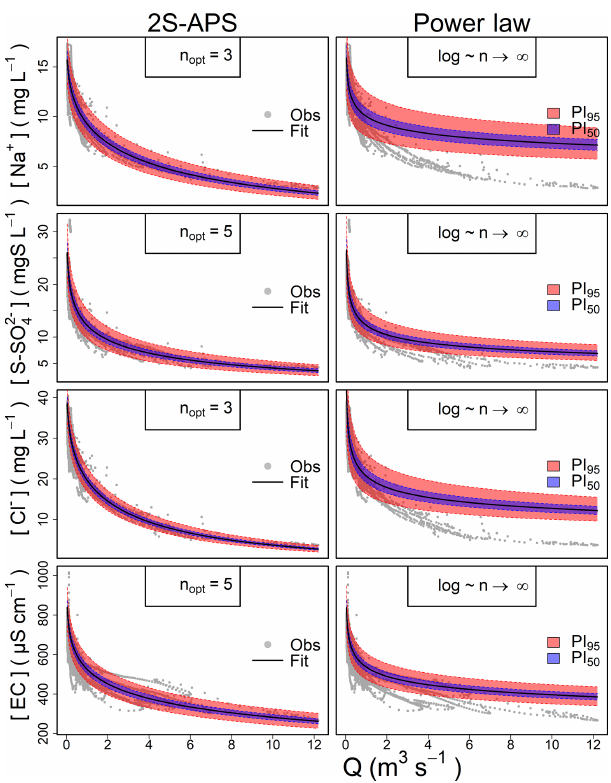
Figure A2. Predictive confidence interval computed for the 2S-APS relationship and the power law for the three ions and the EC rela- tionship. In blue the 50% and in red the 95% predictive confidence